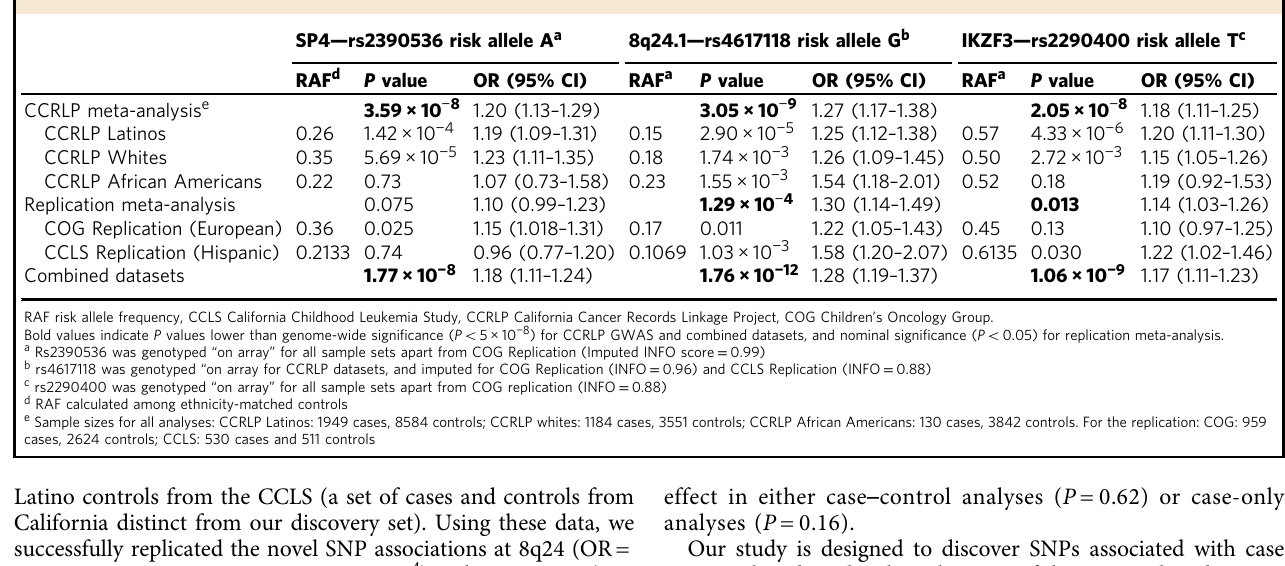
Table 1 Lead SNPs near SP4 , 8q24, and IKZF3 reaching genome-wide signi fi cance in discovery analyses of CCRLP acute lymphoblastic leukemia patients, including replication analyses in the Children ’ s Oncology Group and the California Childhood Leukemia Study Latino Participants